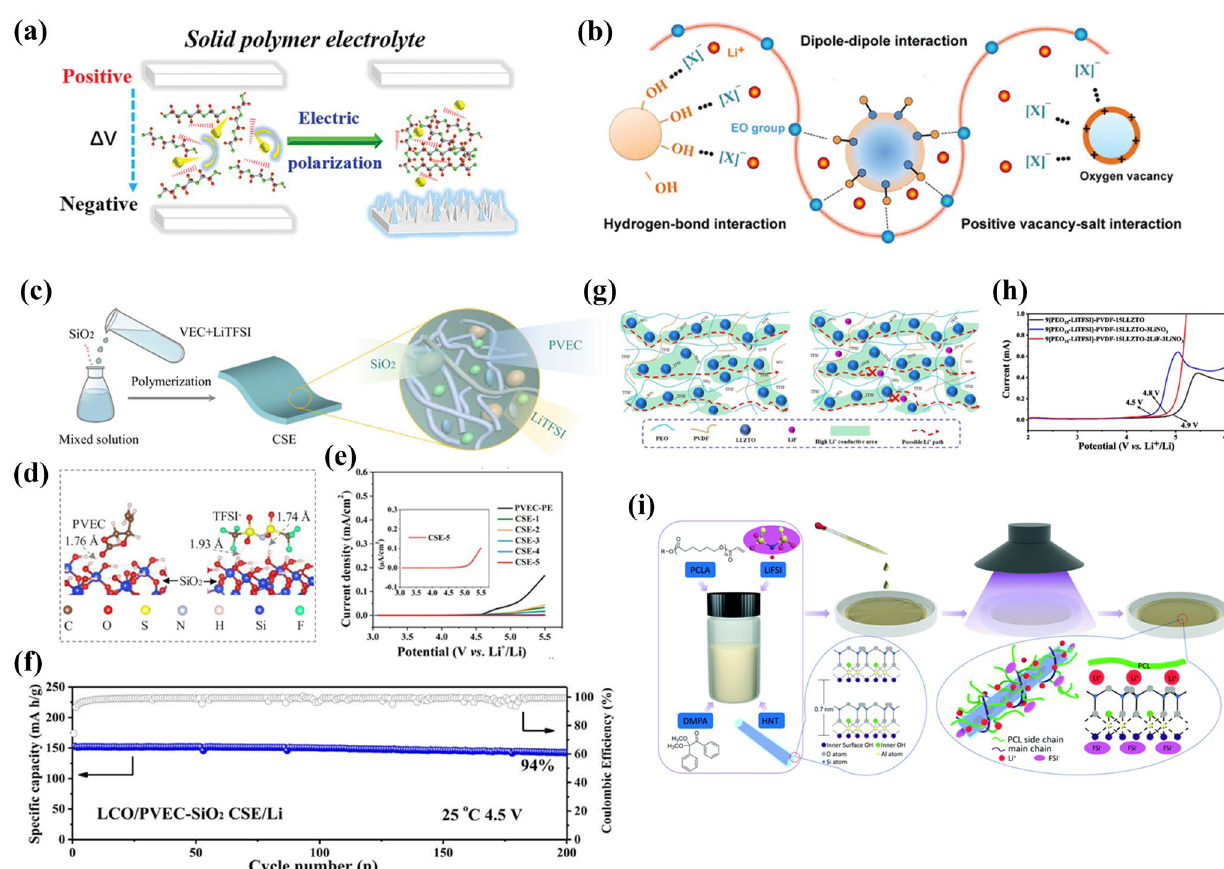
Fig. 15 a Schematic for the electrochemical attenuation with the electric field. Adapted with permission from Ref. [160]. b Lewis acid–base interactions between inorganic additives and polymers. Adapted with permission from Ref. [36]. c Schematic diagram of preparing the PVEC- SiO 2 CPEs; d Intermolecular interaction in PVEC-SiO 2 CPEs by DFT; e electrochemical stability window of PVEC-SiO 2 CPEs; f cycling stabil- ity of PVEC-SiO 2 CPEs. Adapted with permission from Ref. [161]. g Diagram of lithium-ion conductive pathways without and with LiF addi- tive; h Comparison of LSV results of LLZTO-PEO/PVDF CSEs with different additives. Adapted with permission from Ref. [162]. i Schematic illustration of the preparation of the HNTs-PCL CPEs. Adapted with permission from Ref.